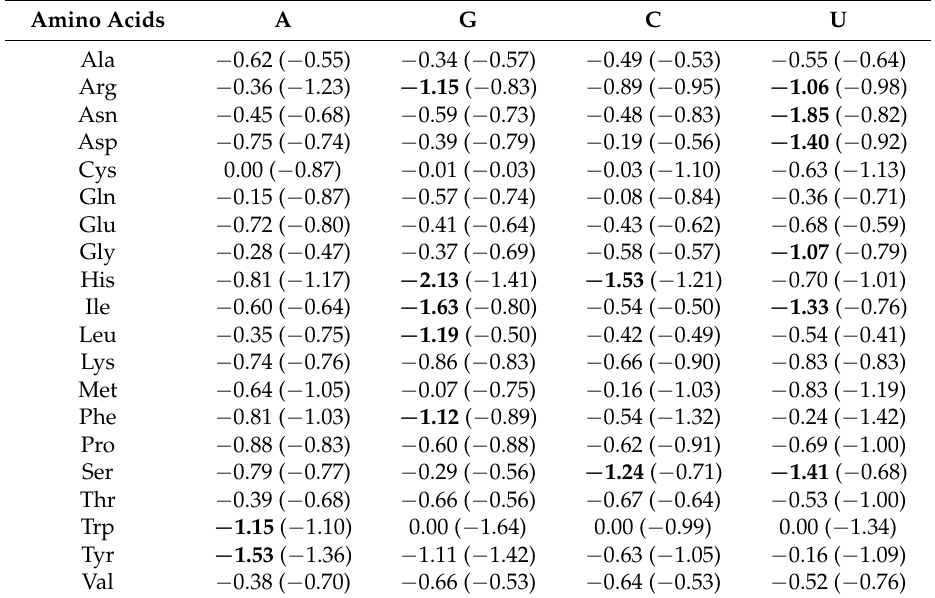
Table 5. Interaction energy between amino acids and nucleotides in DOT regions. Amino Acids